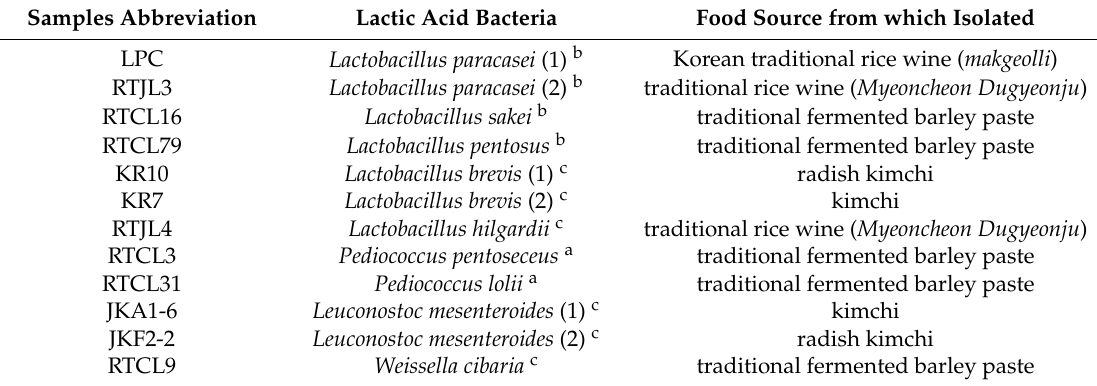
Table 3. The abbreviation of fermented rice samples and the strains of lactic acid bacteria used in the present